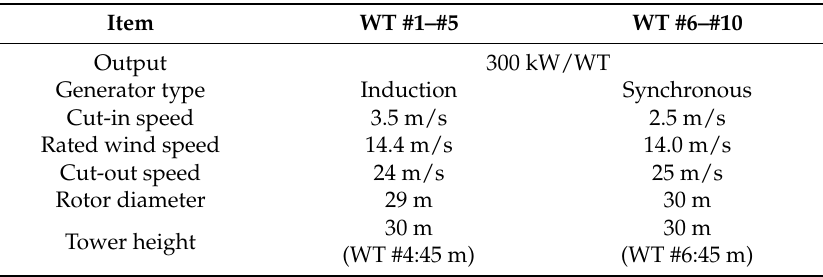
Table 2. WT hub-heights and surface elevations.